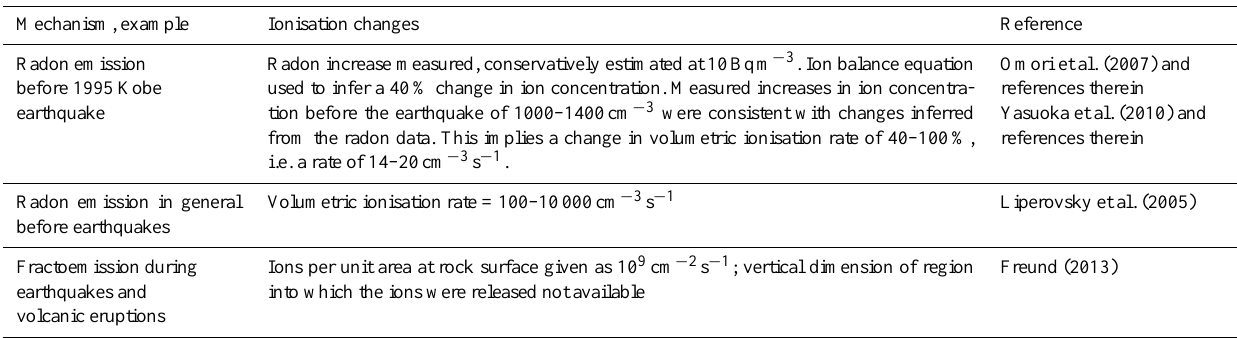
Table 1. Summary and quantitative estimates of mechanisms by which rock stresses can produce excess ionisation in surface air before